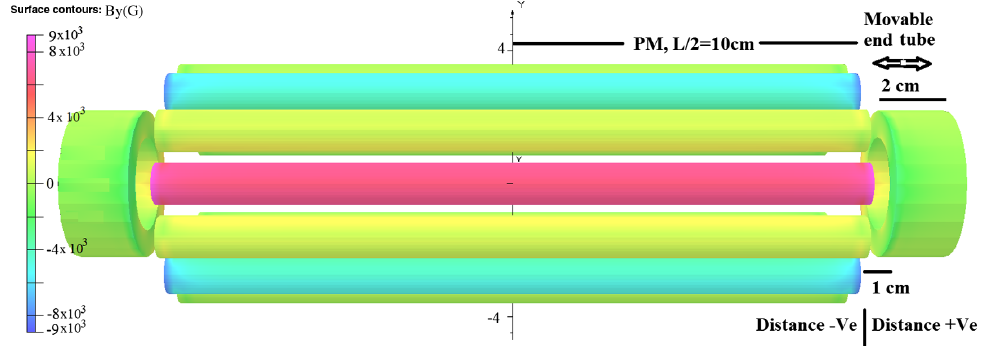
FIG. 9. Position of 2-cm-long end tubes, one at each end of the 12 PM block assembly. The integrated field strength can be varied by varying the distance of the end tubes from the edge of the